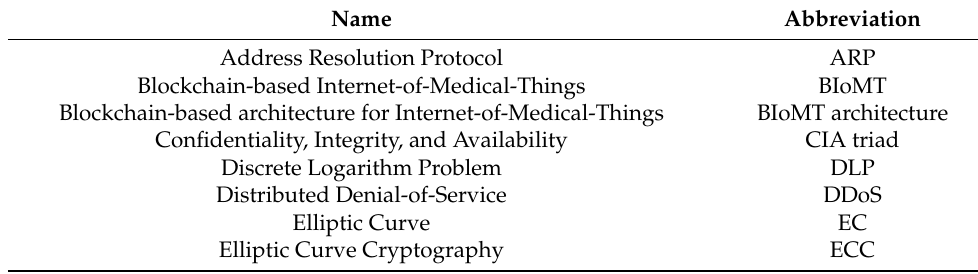
Table 1. Abbreviations used in the